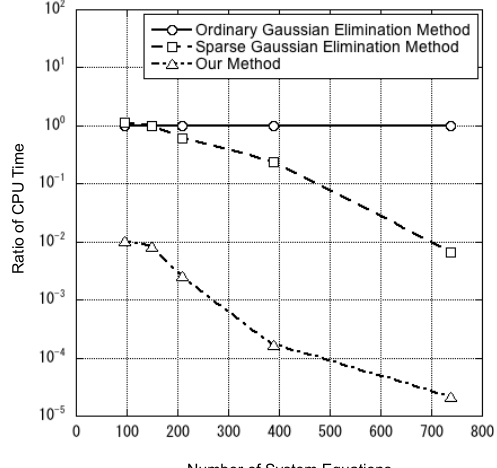
tableau approach to network analysis and design, IEEE